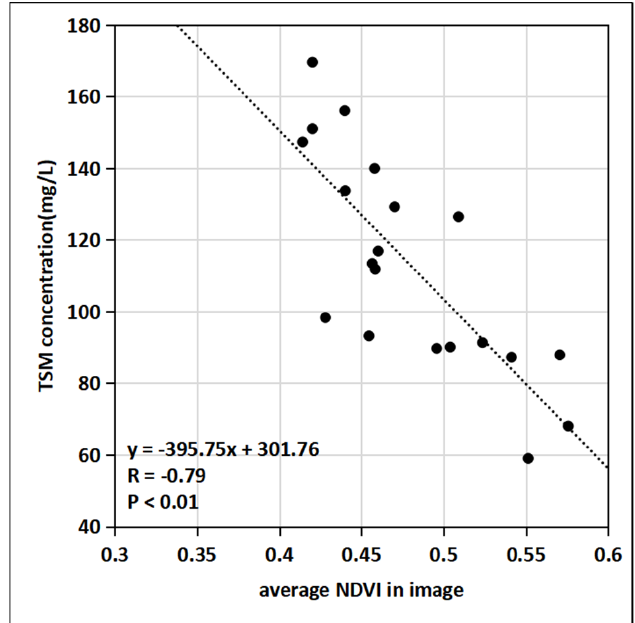
Figure 15. Correlation between the mean NDVI value for the Landsat image and C TSM at the mouth of the river in the period 2000–2019.